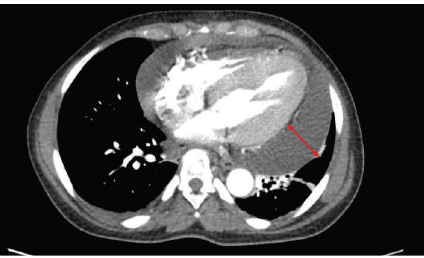
Figure 4: Chest CT with angiography: axial view at midthoracic level shows large pericardial efusion (red line) without pericardial or pleural thickening, or pericardial or pleural masses.